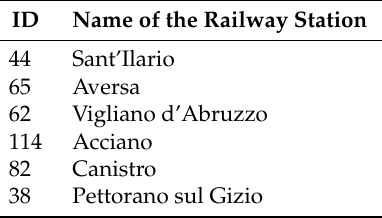
Table 4. The most exposed